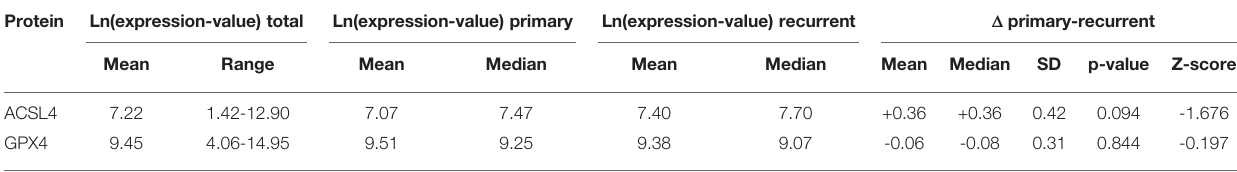
TABLE 4 | Summary of the TCGA analysis.